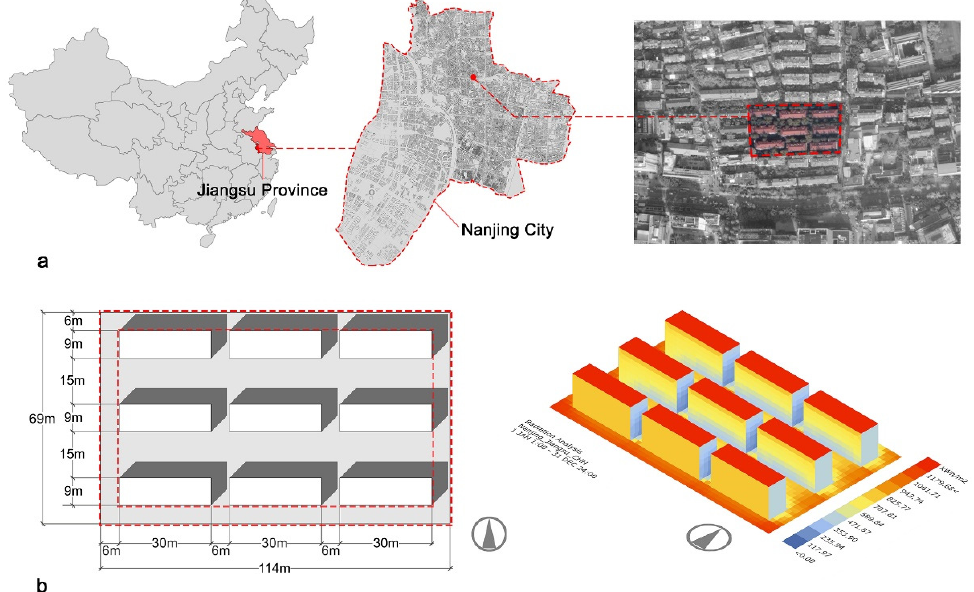
Figure 2. ( a ) Site location, ( b ) initial morphology and solar information.